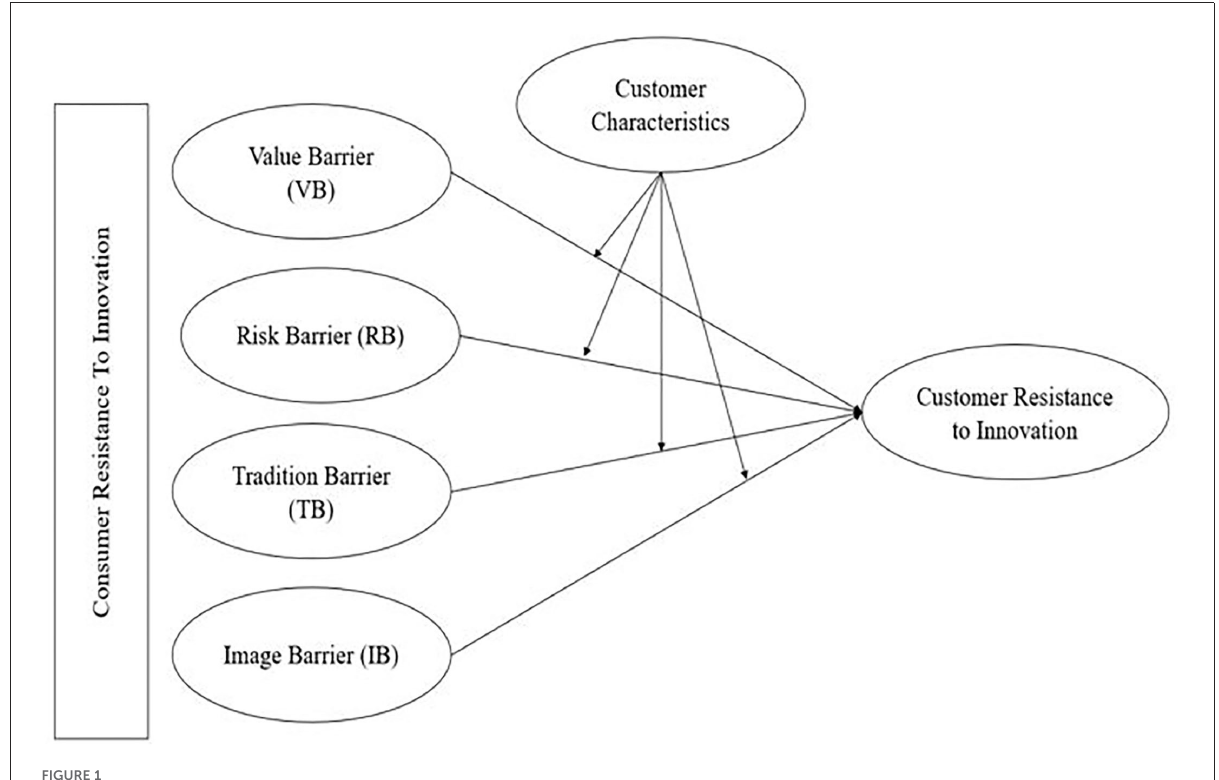
FIGURE1 Research